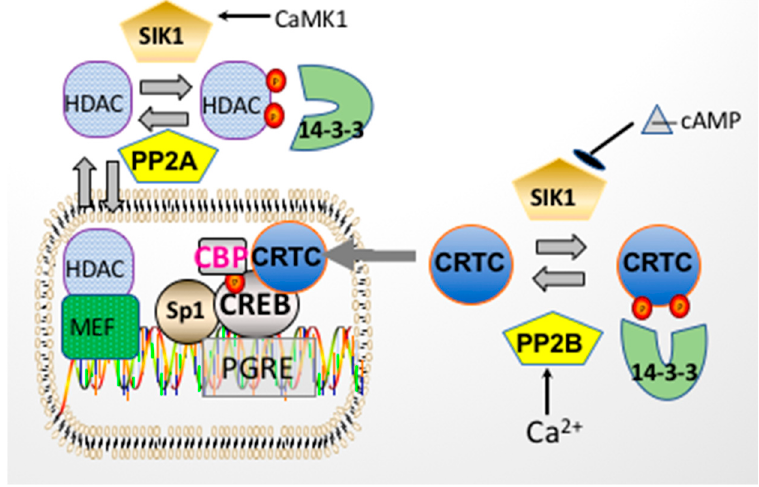
Figure 5. Regulation of atp1b1 transcription by CRTCs and Class IIa HDACs. CRTCs are phosphorylated by SIK1, and translocate to the cytoplasm where they interact with 14-3-3. When SIK1 is phosphorylated and inactivated by PKA, CRTCs are then dephosphorylated by PP2B (i.e., calcineurin), provided that PP2B is activated by Ca 2+ /calmodulin. When SIK1 is phosphorylated and activated by CaMK1, SIK1 phosphorylates class IIa HDACs, which then dissociate from MEF2 transcription factors, activating transcription by MEF2. Phosphorylated class IIa HDACs translocate to the cytoplasm where they are sequestered by 14-3-3 proteins.